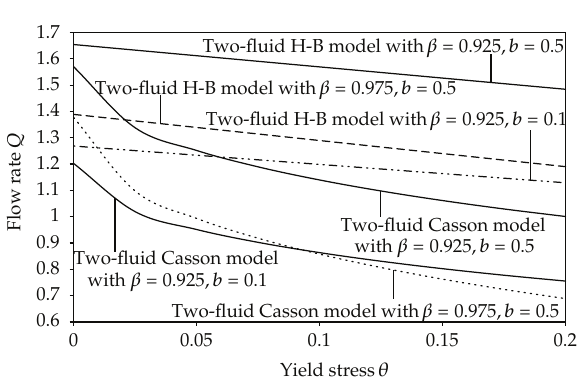
Figure 8: Variation of flow arte with yield stress for two-fluid H-B and Casson models and di ff erent values of b and β with t (cid:7) 60 ◦ , B (cid:7) 1, ψ (cid:7) − 0 . 1, n (cid:7) 0 . 95, δ P (cid:7) 0 . 1, φ (cid:7) α (cid:7) α H (cid:7) α C (cid:7) 0 . 2, ω (cid:7) 1, and z (cid:7) 2 . 3.